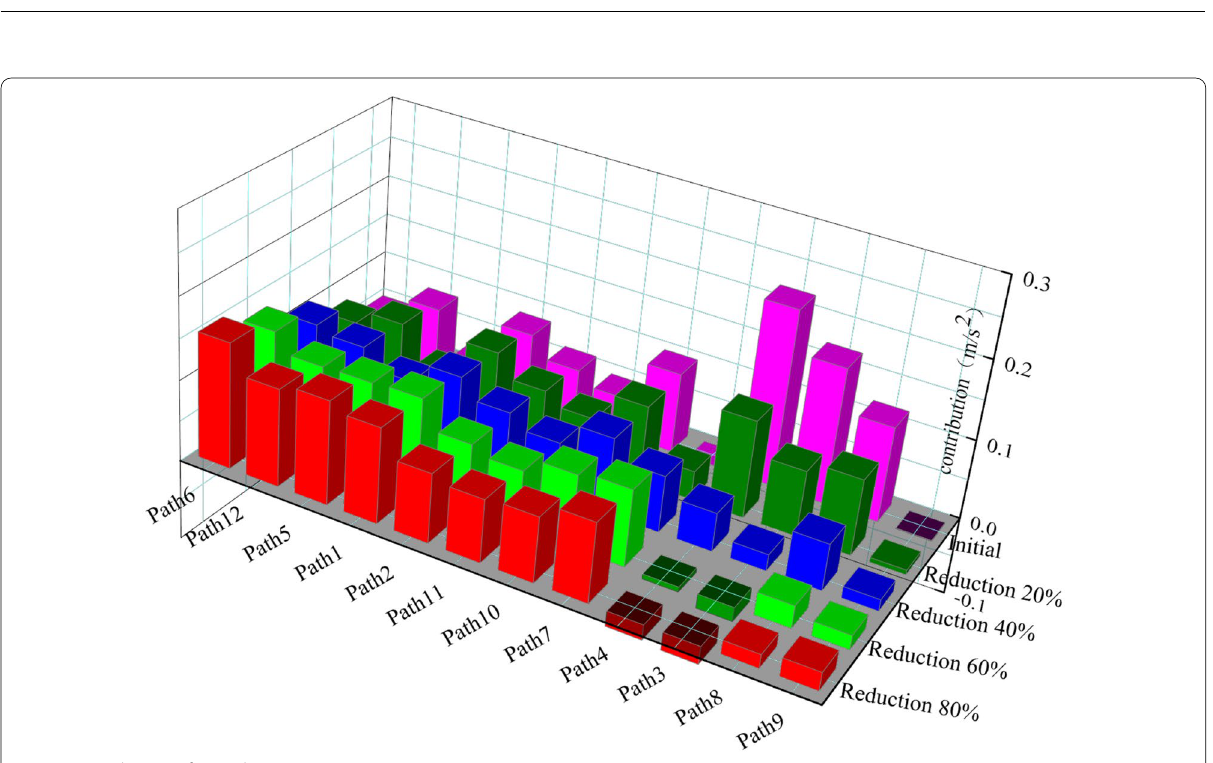
Figure 13 Change of